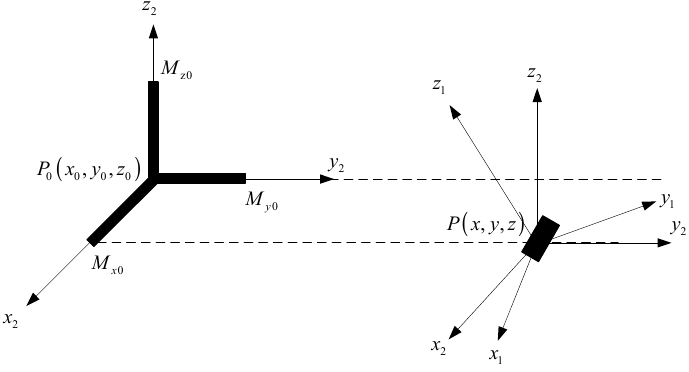
Figure 3. The position relationship between the target and the sensor.